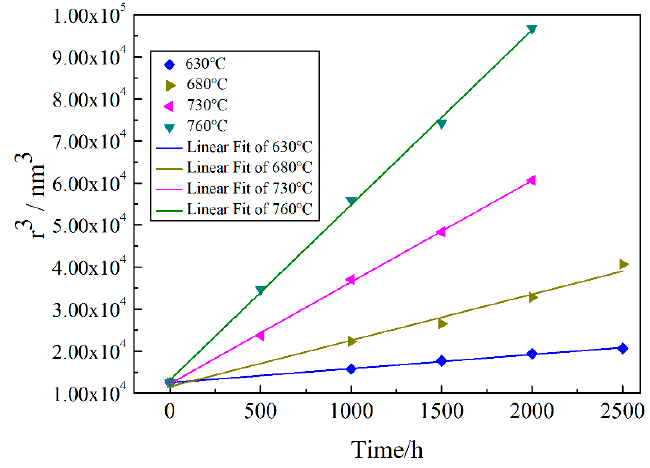
Figure 7. The linear fit plots of r 3 vs. t of the tertiary γ’ precipitates.